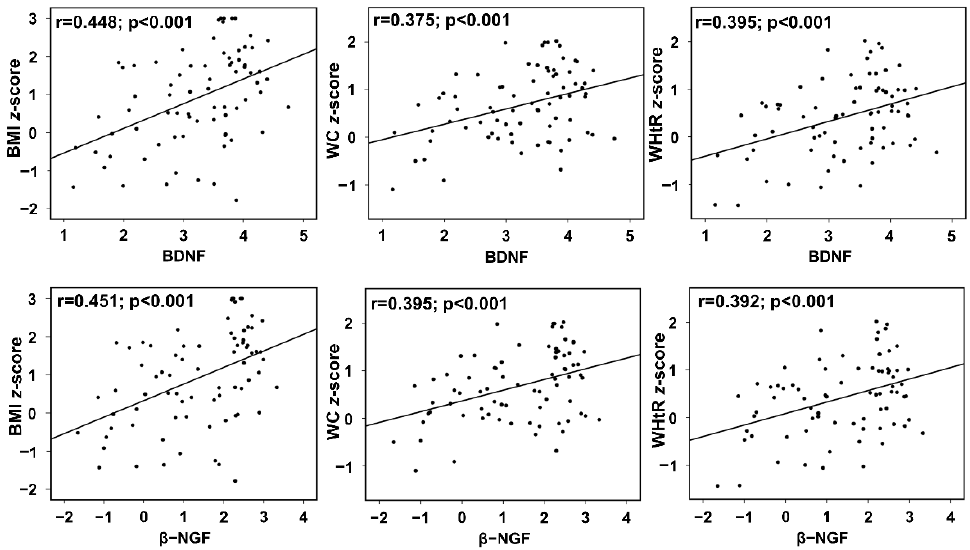
Figure 2. Correlation between anthropometric measurements BMI z-score, WC z-score, and WHtR z-score with neurotrophins BDNF and NGF.